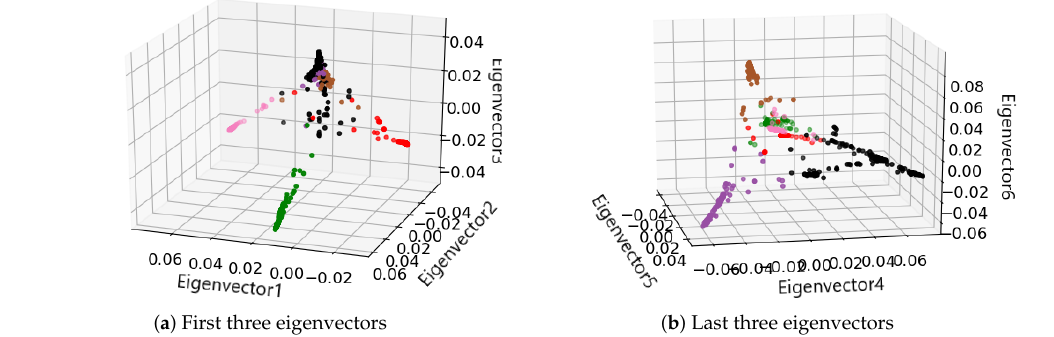
Figure 3. Three-dimensional spaces constructed by ( a ) the first three eigenvectors and ( b ) the last three eigenvectors. Different colors denote different clusters output by spectral clustering.